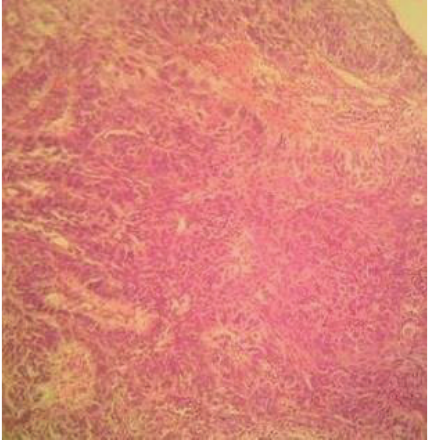
Figure 4: Histological view of the breast mass showing typical structure squamous cell carcinoma (hematoxylin and eosin, × 100).